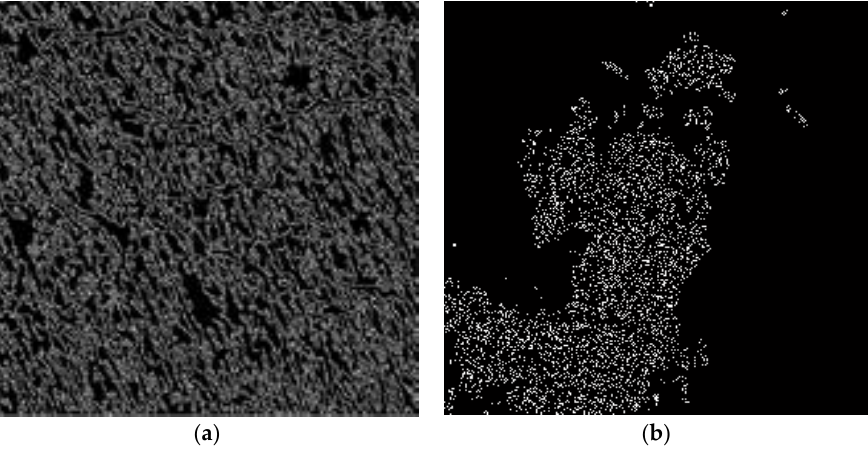
Figure 9. The localization results by Canny. ( a ) The results of strong waves; ( b ) the results of cloud coverage.